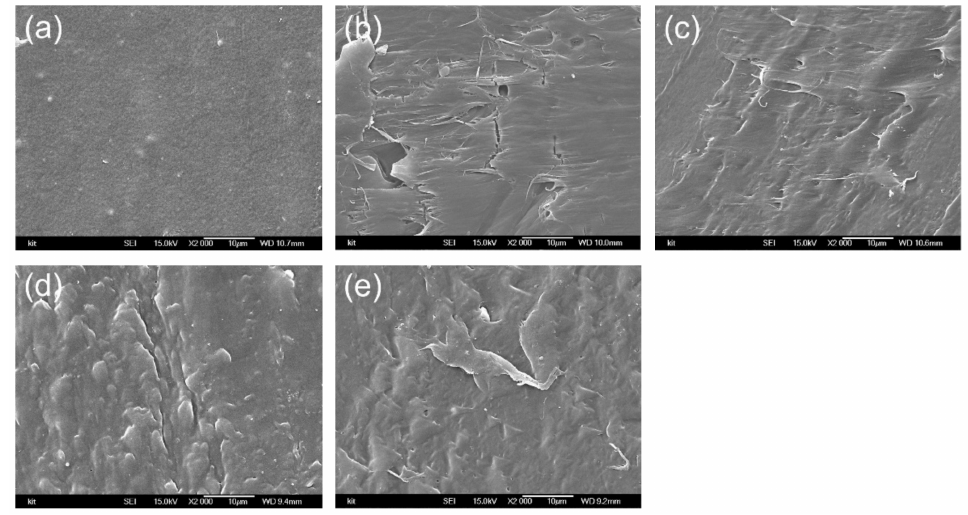
Figure 9. SEM images of polyethylene (PE) aggregate: ( a ) 0 kGy; ( b ) 25 kGy; ( c ) 50 kGy; ( d ) 75 kGy;